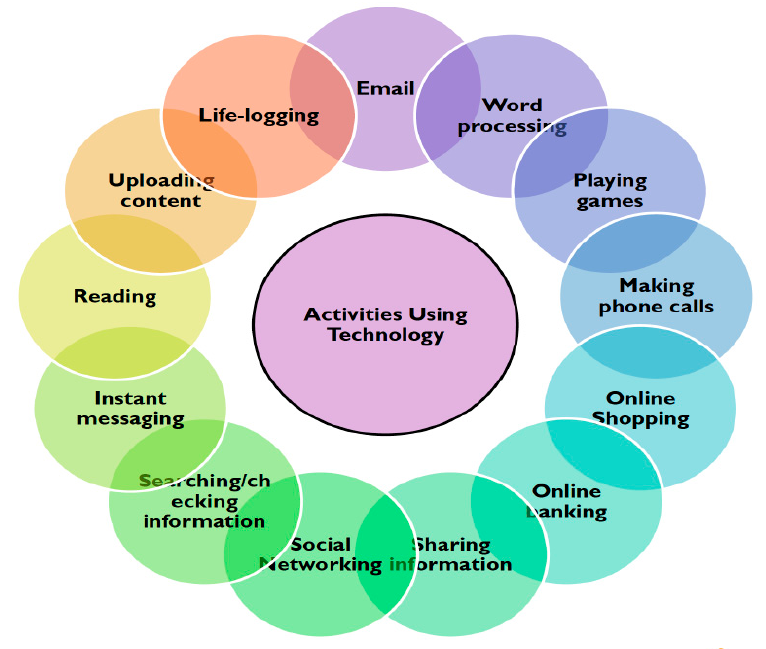
Figure 1. Participant reasons for using technology.